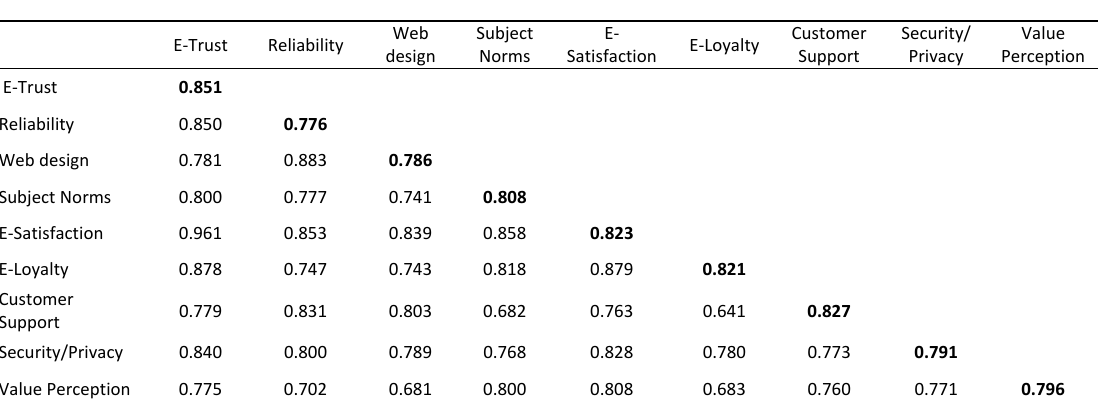
Table 4: Validity discrnment